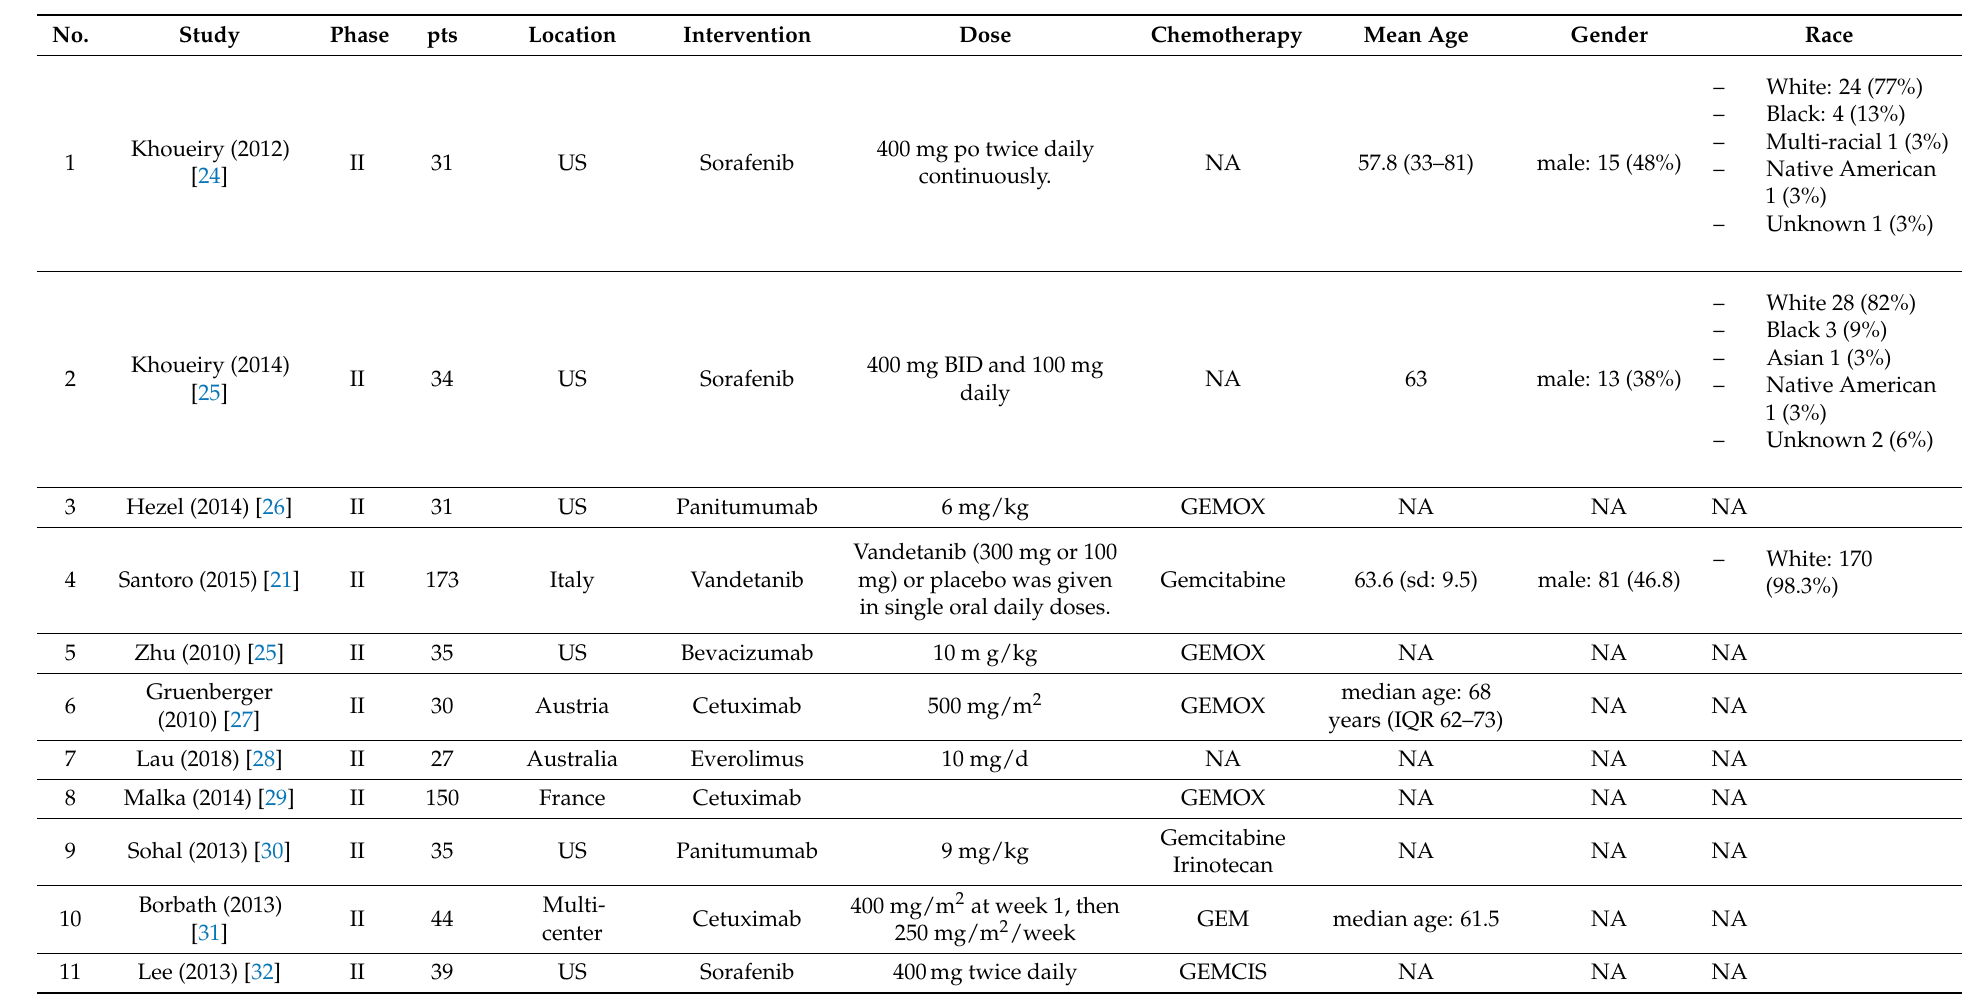
Table 2. Basic characteristics of targeted